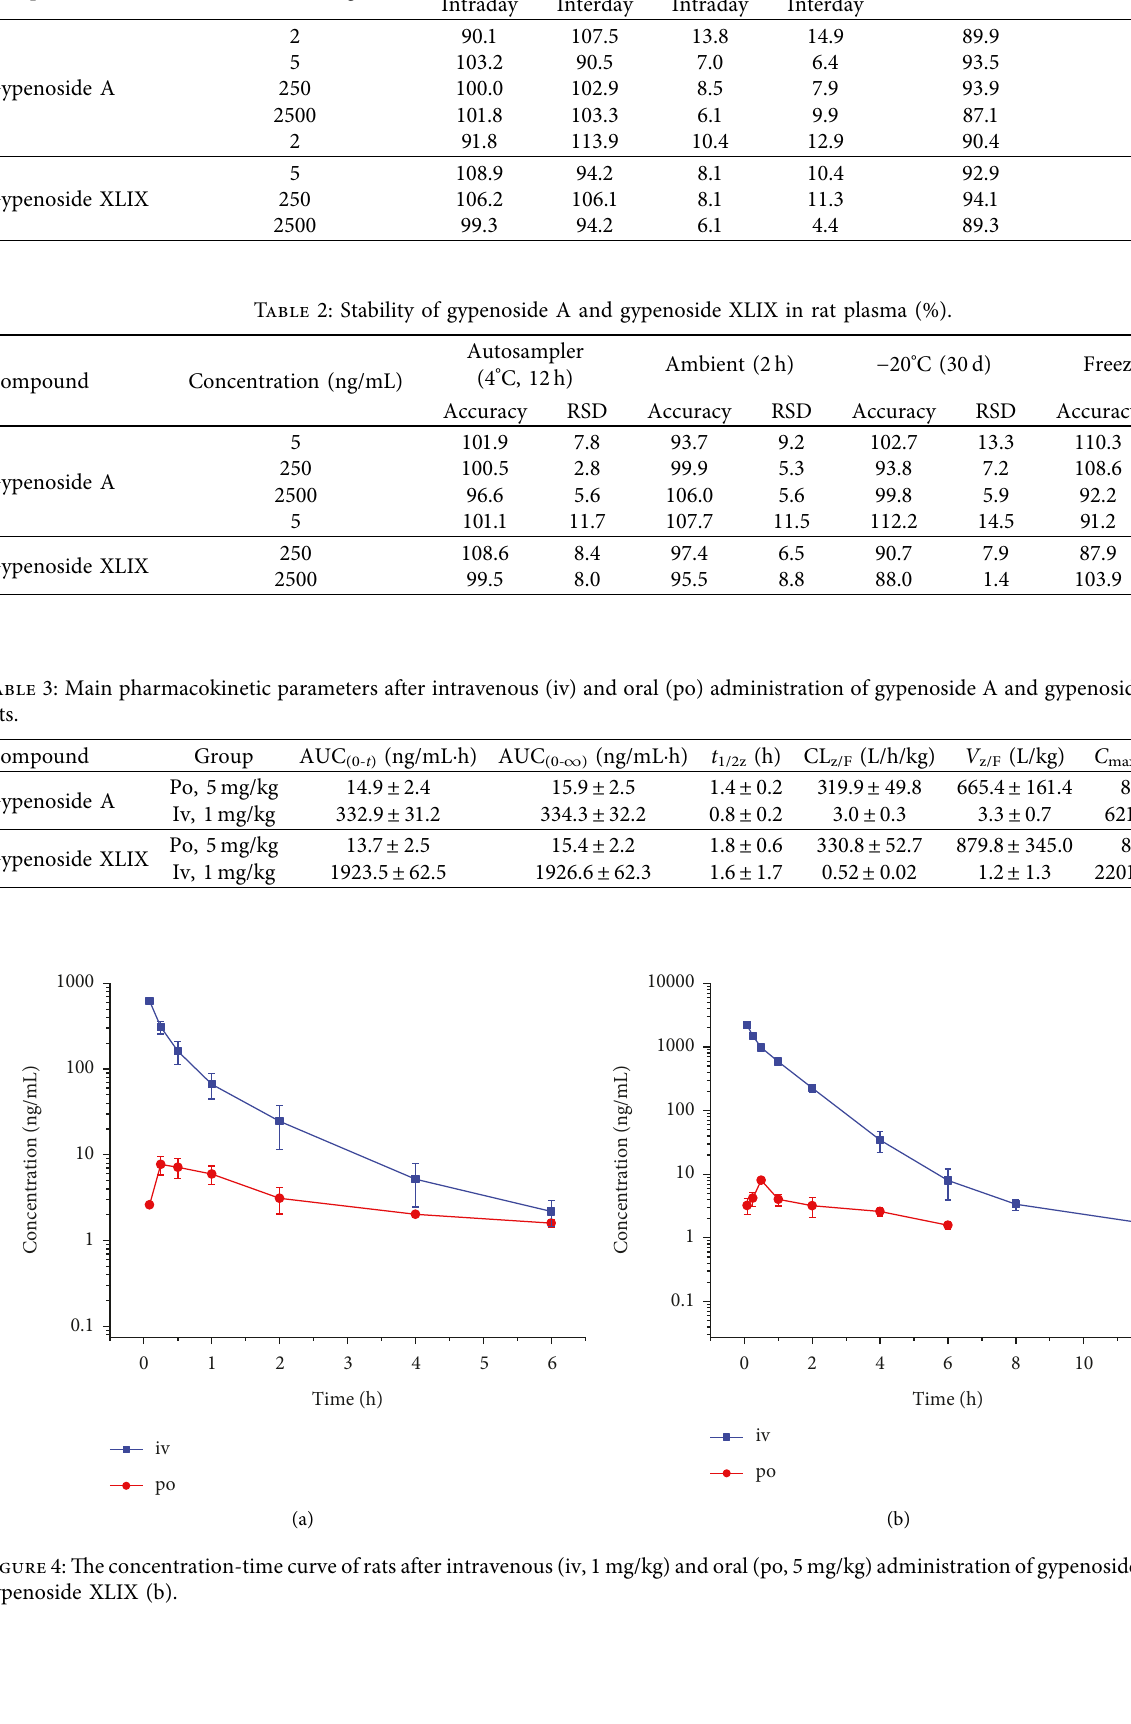
Table 1: Accuracy, precision, matrix effect, and recovery of gypenoside A and gypenoside XLIX in rat plasma. Compound